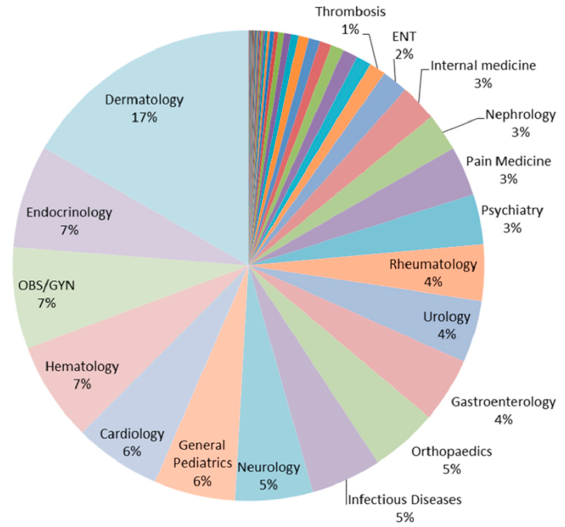
Figure 1. Specialty distribution for all cases completed between 1 April 2014 and 31 March 2015 ( n = 3670). ENT = ears, nose, and throat; OBS/GYN = Obstetrics and gynecology